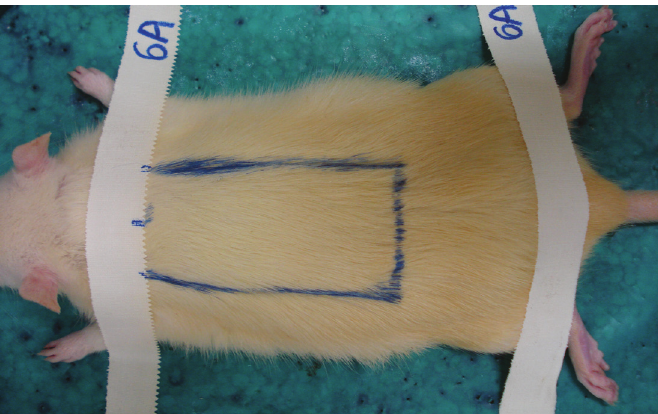
FIGURE 1 – Photography of an animal in ventral decubitus, with the limbs in extension. Demarcation of the dorsal flap, using the inferior angles of the scapula as a